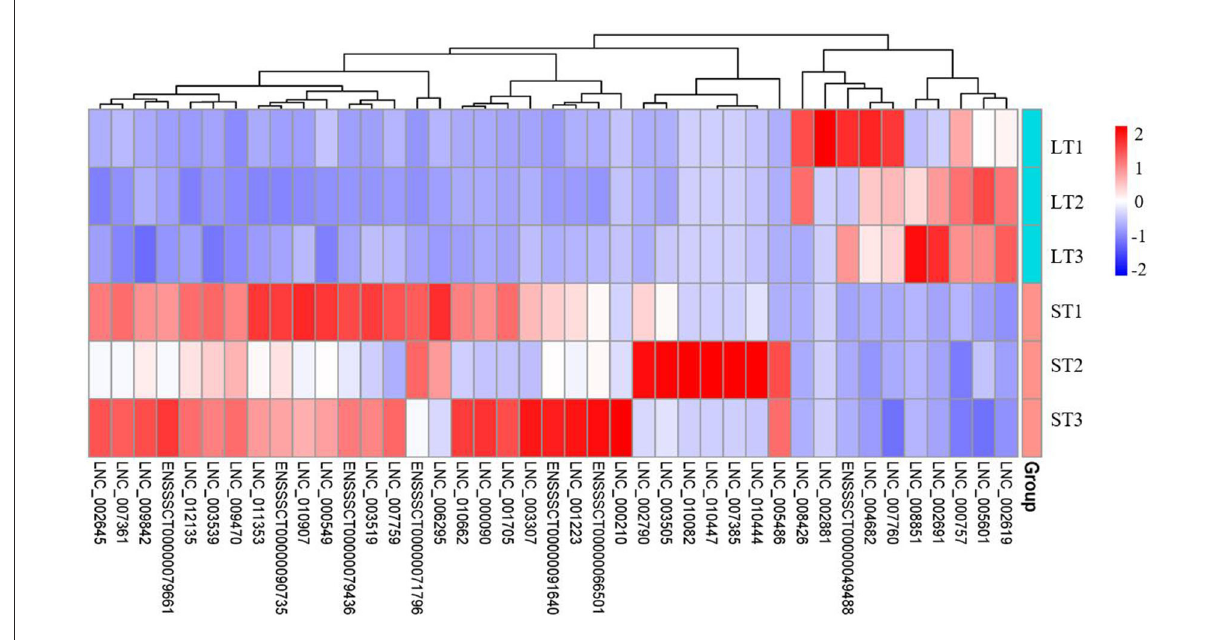
FIGURE6 Hierarchical clustering heatmap of key